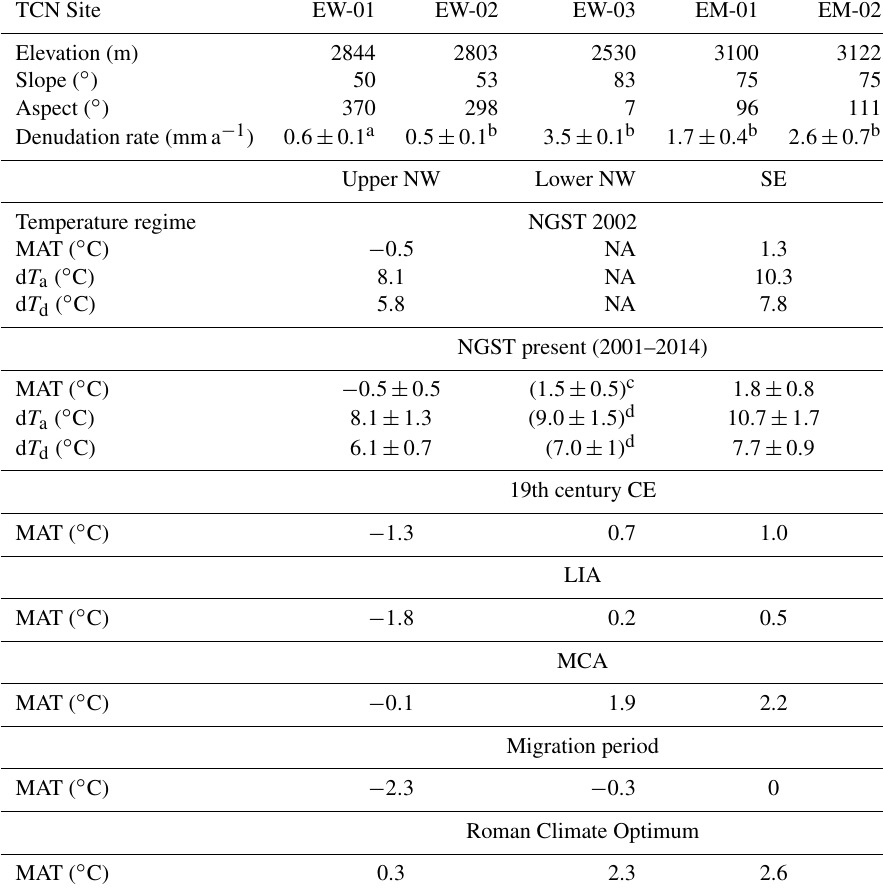
Table 1. Study site parameters and reconstructed temperature values. NGST sites from Gruber et al. (2004b); temperature data available at http://www.permos.ch/data.html (last access: 7 May 2020, PERMOS, 2019). For the record used, see the “Methods” section. a Rate dependent on 10 Be blank correction (see Appendix A); b data from Mair et al. (2019); c MAT scaled from the Eigerfenster site (Gruber et al., 2004b); d values assumed (see Sect. 3.2 for details). TCN: terrestrial cosmogenic nuclide; NGST: near-ground surface temperatures at a depth of 10cm; LIA: Little Ice Age; MCA: Medieval Climate Optimum; MAT: mean annual temperature; d T a : amplitude of annual temperature variation; d T d : mean amplitude of diurnal variation; NA: not available. TCN Site